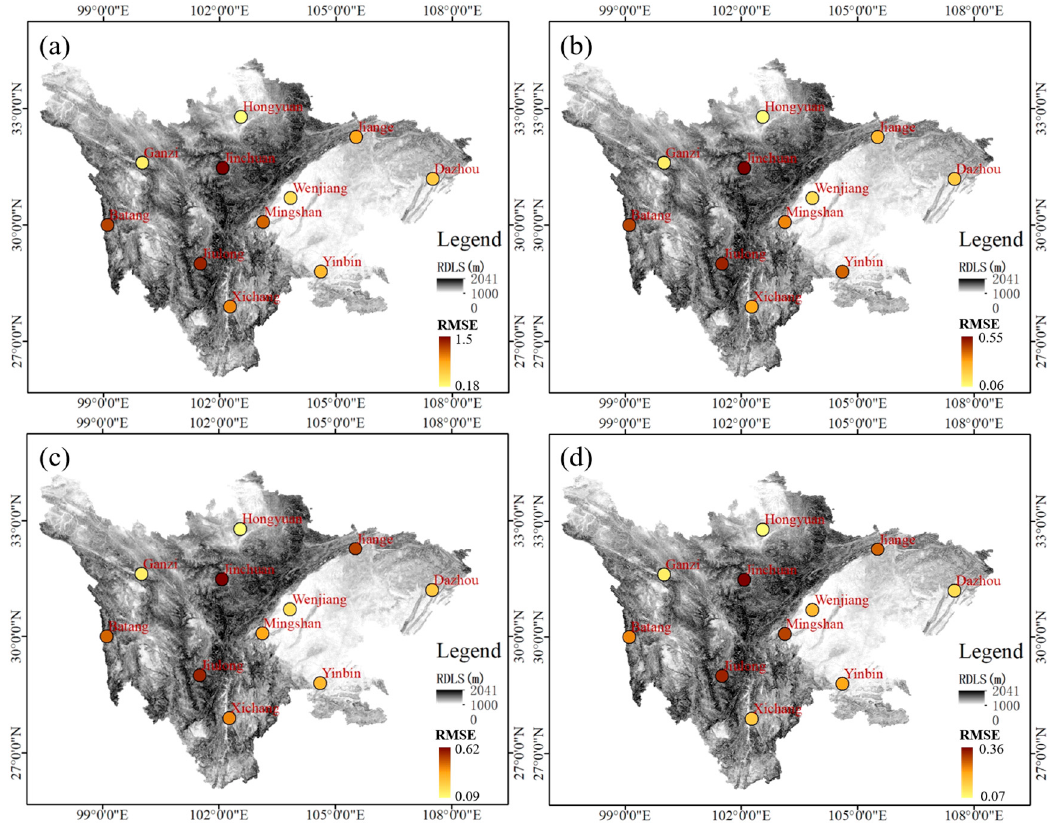
Figure 10. Spatial distribution of the RMSE and RDLS. ( a ) Whole layer; ( b ) high layer; ( c ) middle layer; ( d ) low layer.